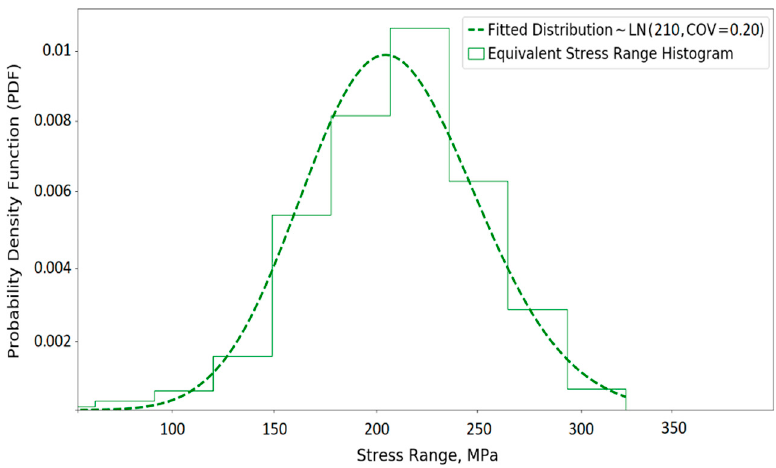
Figure 9. Equivalent stress range histogram and the fitted distribution.